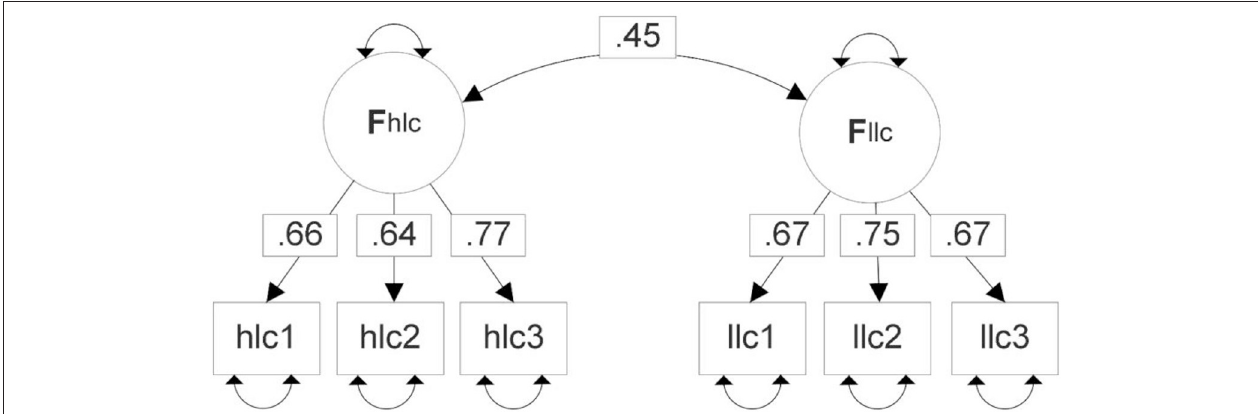
FIGURE 3 | CFA model for